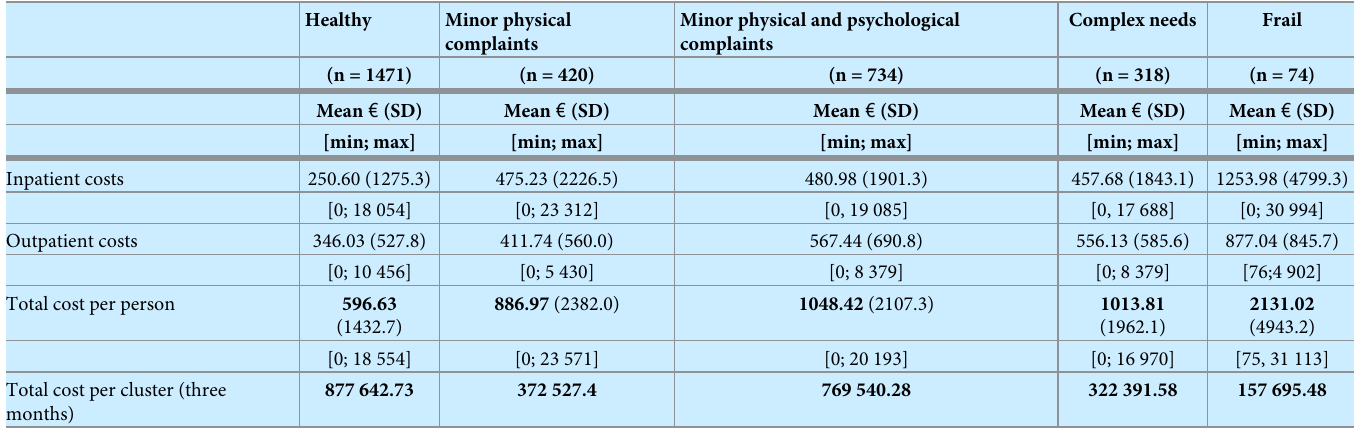
Table 4. Inpatient and outpatient costs in the various clusters.